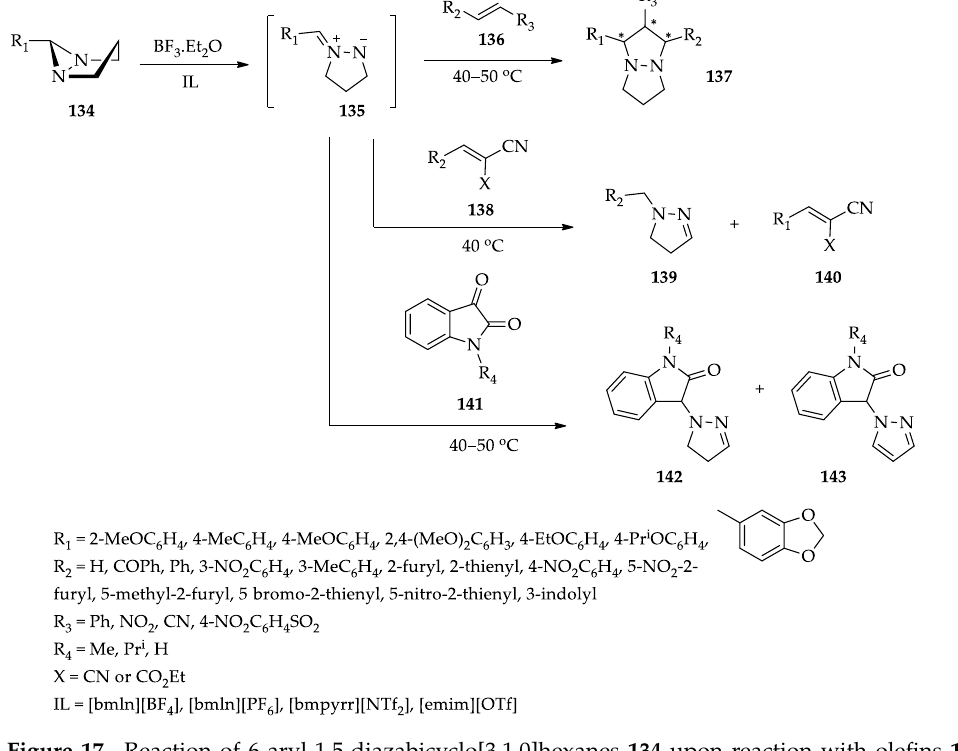
Figure 17. Reaction of 6-aryl-1,5-diazabicyclo[3.1.0]hexanes 134 upon reaction with olefins 136 , arylidenemalononitrile 138 , and 1 H -indole-2,3-diones 141 in ionic liquids.